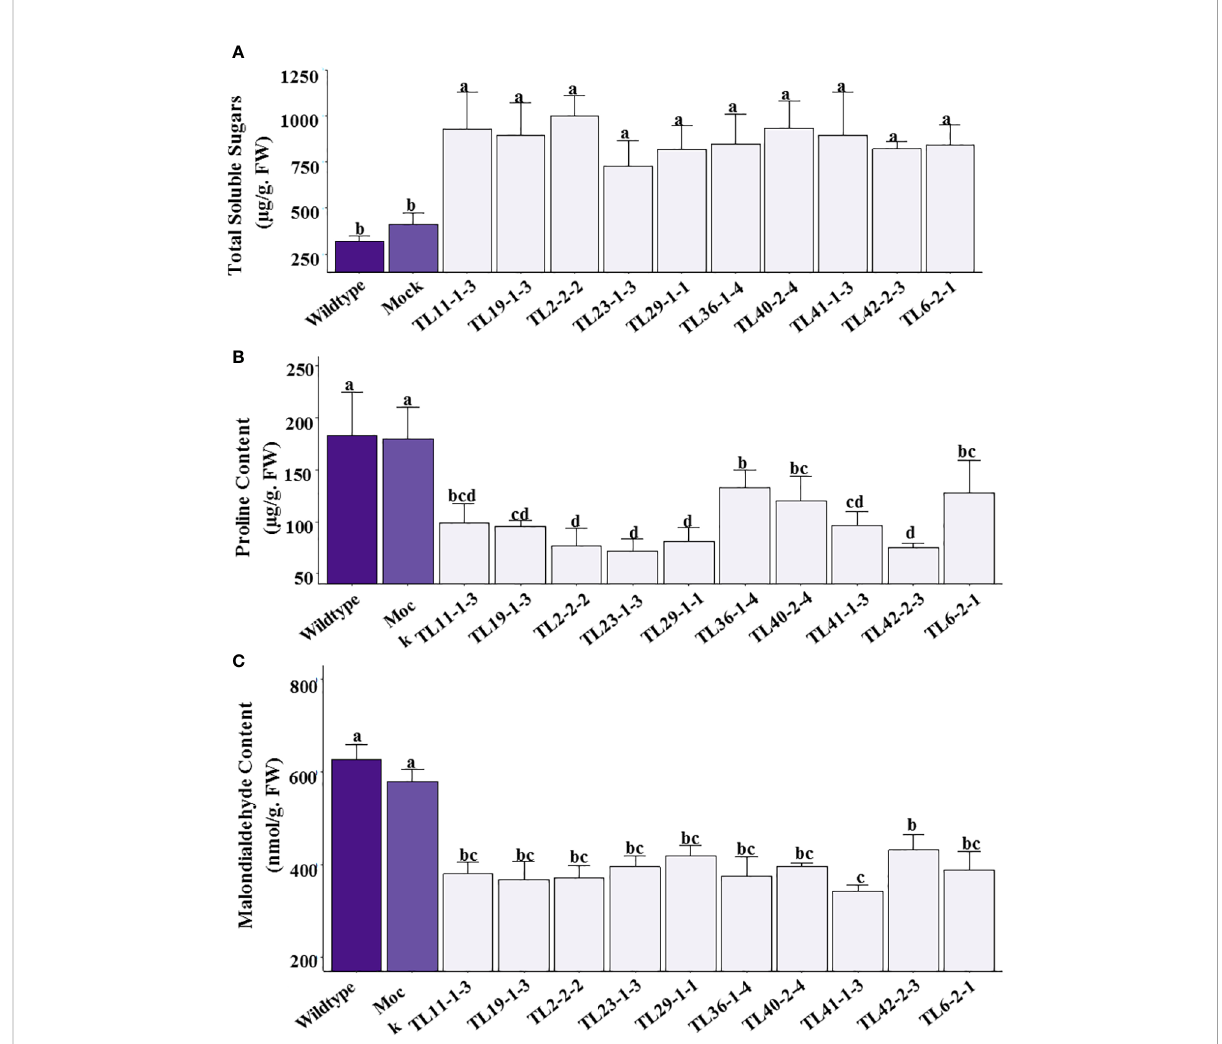
FIGURE 8 Osmolytes and Malondialdehyde content in multigene transgenic lines, wild type and mock plants under drought stress: (A) . Total soluble sugars, (B) . Free proline content, and (C) . Malondialdehyde content. The values are mean of three biological replicates (n=3) and error bars denotes standard error. The alphabets on the error bars indicates signi fi cant variation ( p ≤ 0.05) between transgenic lines, wild type and mock